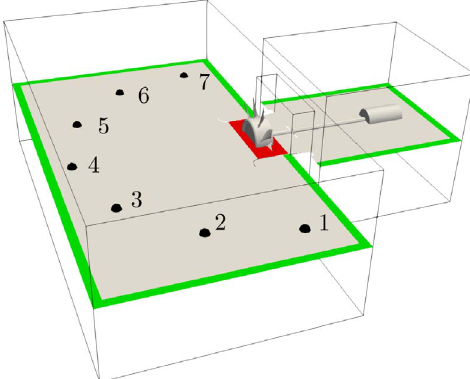
Figure 18. Acoustic mesh regions, with the PML in green, stationary inlet and outlet regions in gray, the rotating region in red and the microphone positions in